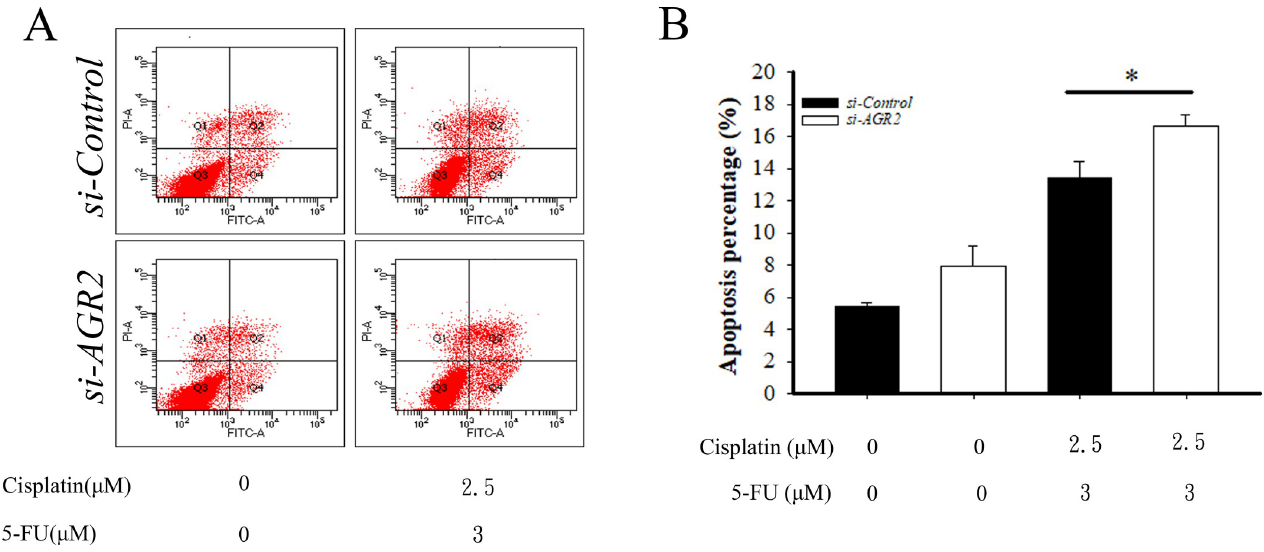
PLOS ONE | https://doi.org/10.1371/journal.pone.0276990 November3,